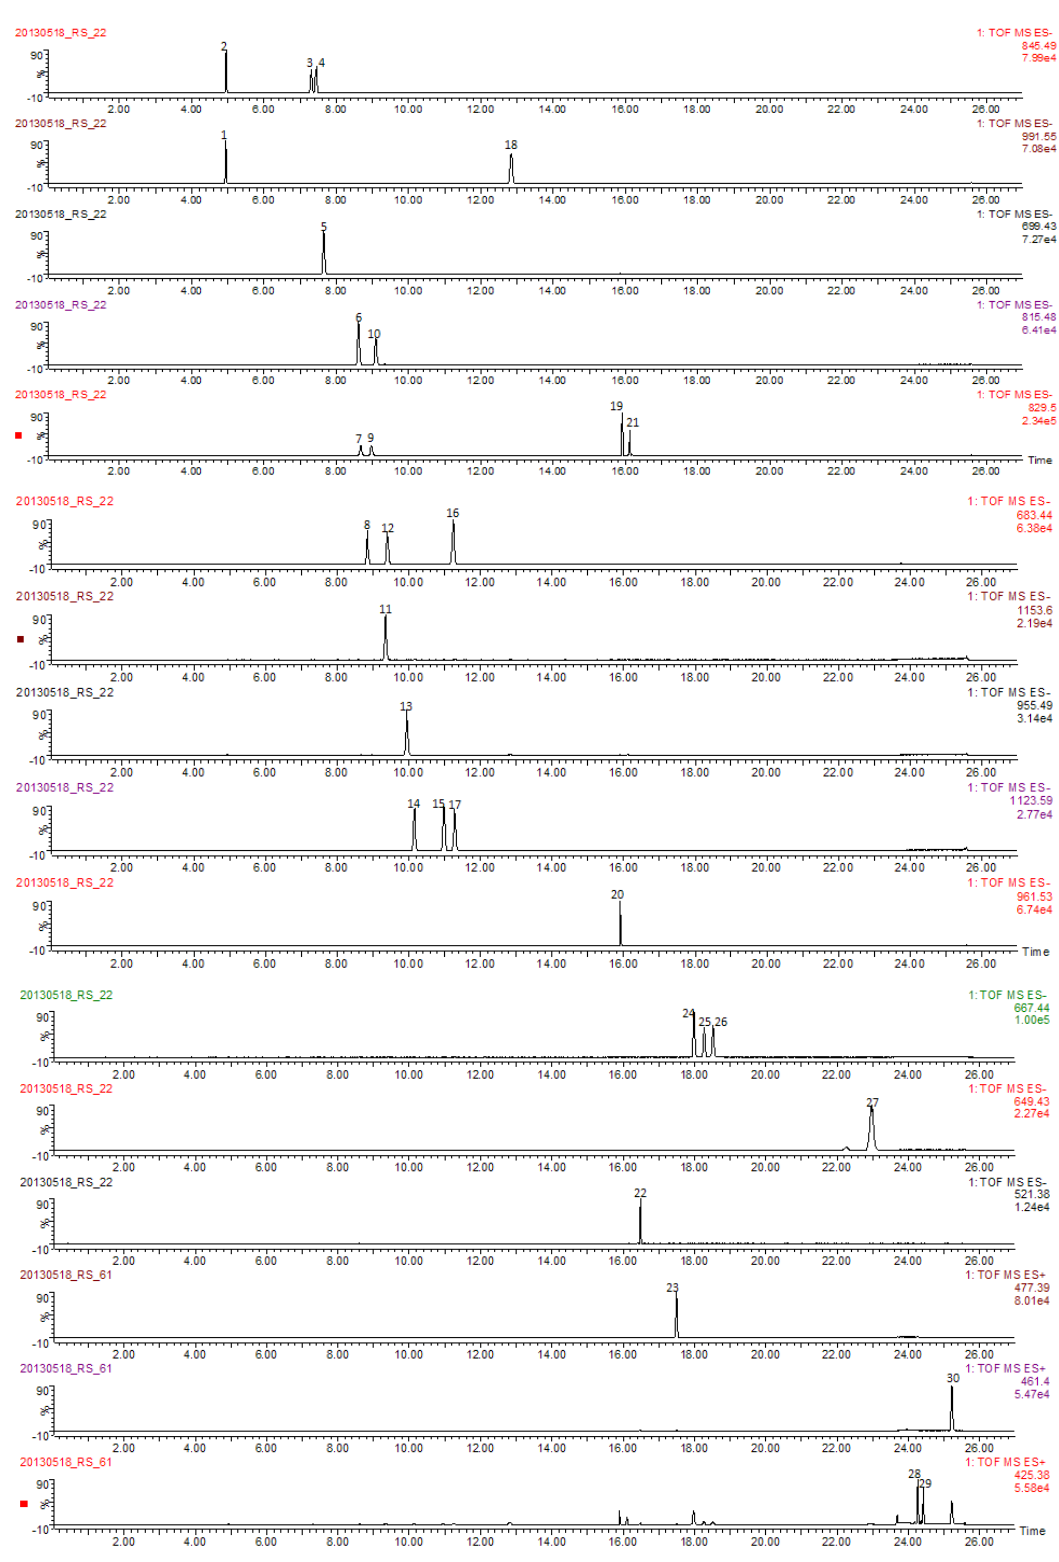
Figure 3. Extracted ion chromatograms of 30 analytes (6.25 μ g/mL each in reference compound mixture solution. Compound codes are the same as those in Figure